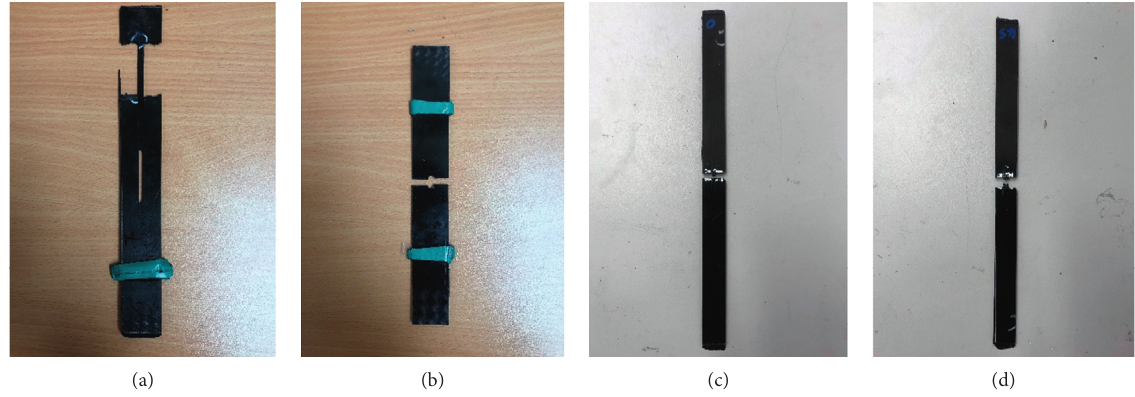
Figure 12: Broken specimens. (a) [0/90/0/90/0 4 ] s . (b) [90/0/90/0/90 4 ] s . (c) [0 8 ] s . (d) [0/45/0/-45/0 4 ] s